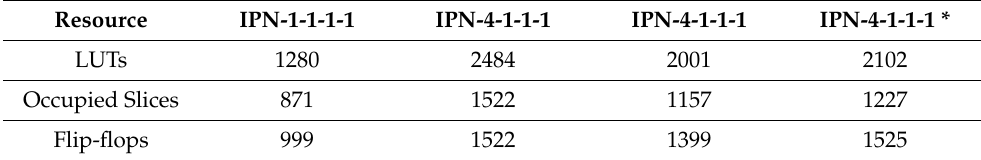
Table 6. Area overhead for implementing a variety of IPNs. The number after each IPN label marks the width at each depth, e.g., IPN-4-1-1-1 is shown in Figure 5. * indicates a reconfigurable IPN.